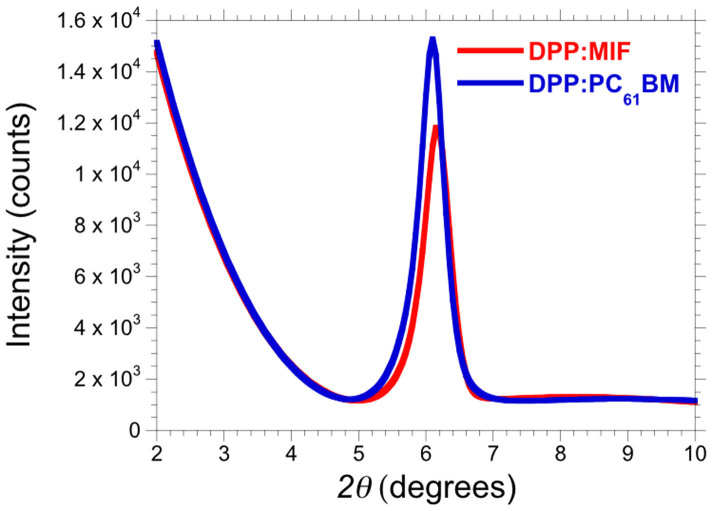
Out of plane XRD diffractograms of SVA treated DPP(TBFu)2:MIF and DPP(TBFu)2:PC61BM thin films on ITO/PEDOT:PSS.